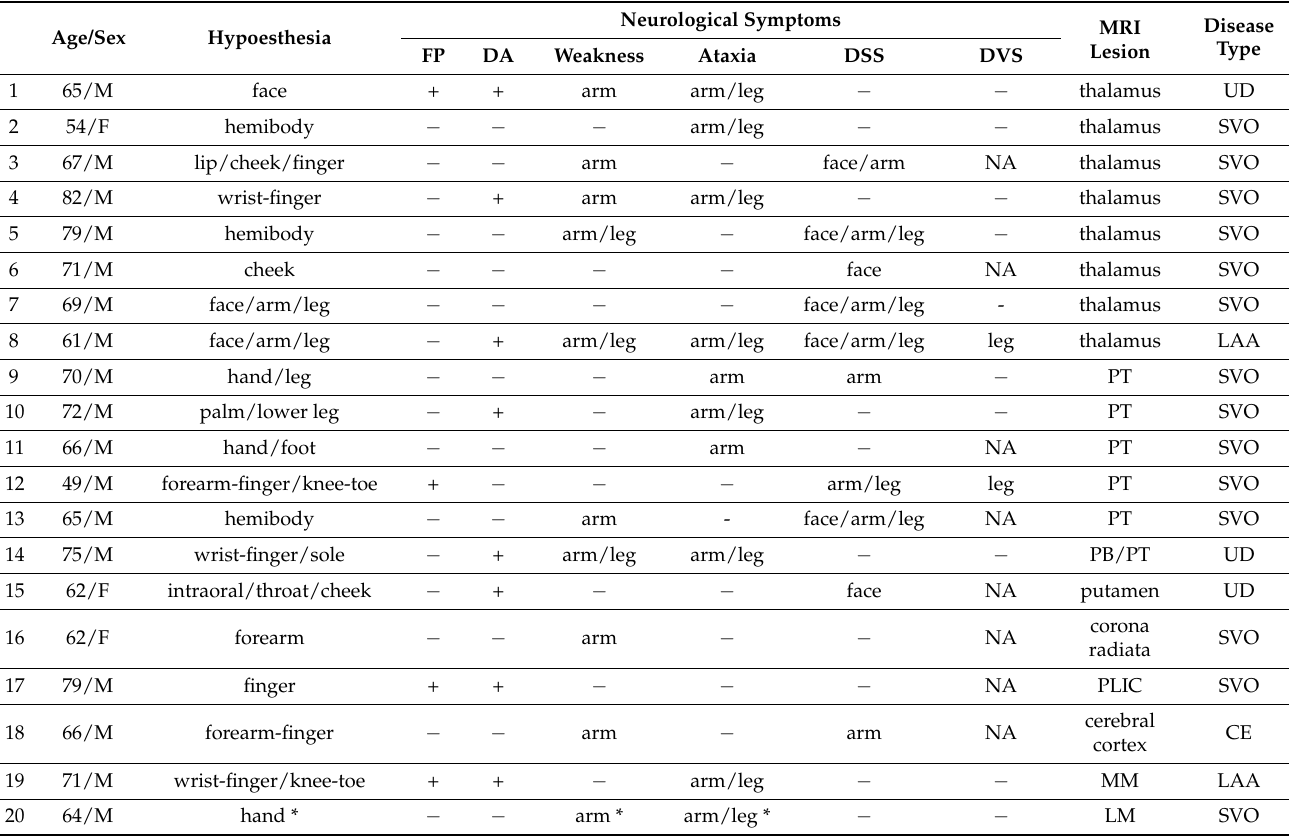
Table 1. Profiles of AIS patients with hypoesthesia as the initial